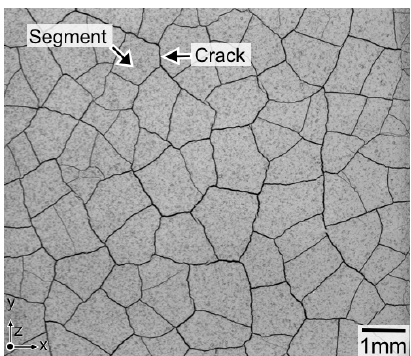
Fig. 2 Typical surface microstructure of EBC system after heat exposure at 1450 ℃ for 2